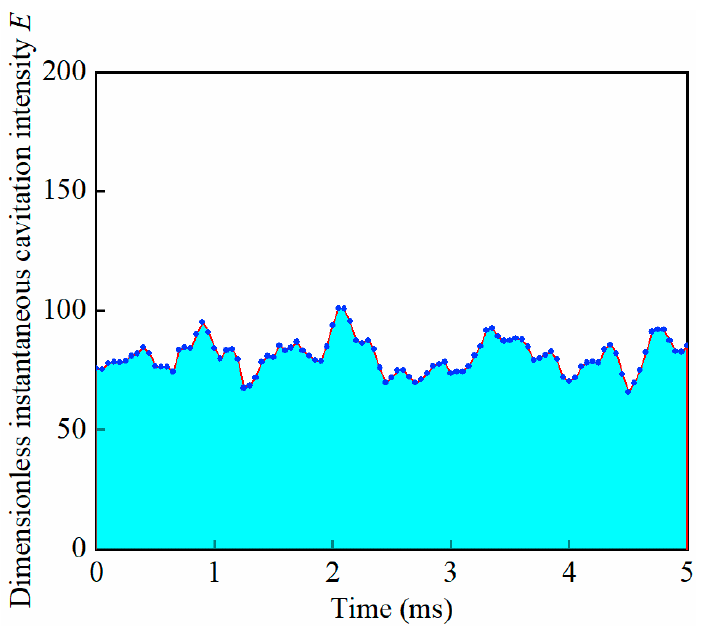
Figure 4. Variation in dimensionless instantaneous cavitation intensity over time, obtained by means of image processing.